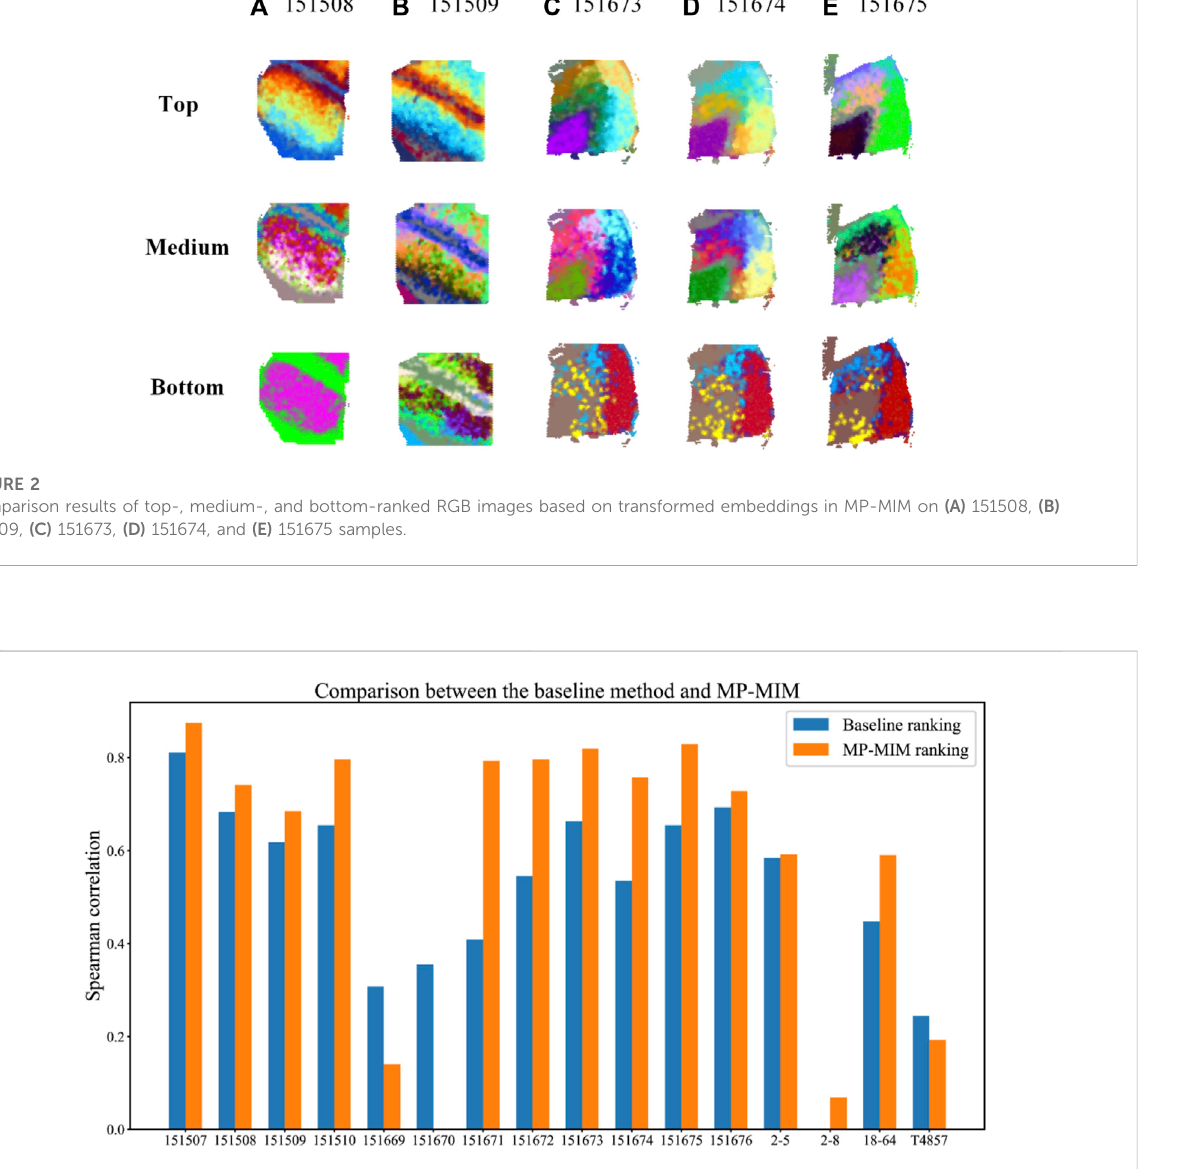
FIGURE 3 Comparison between the baseline method (without applying MP-MIM) and MP-MIM on the 16 samples. In this study, Spearman correlation coef fi cients of the baseline ranking are measured between the ground-truth ranking based on embedding quality according to the ARI and the rankingofthebaselinemethod.TheSpearmancorrelationcoef fi cientsoftheMP-MIM rankingaremeasuredusingtheground-truthrankingandthe ranking of the